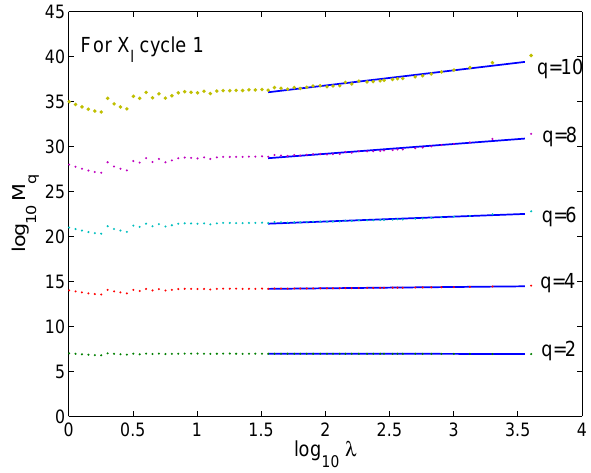
Fig. 2. An example for obtaining the empirical K(q) function. From the plots, we find the best linear fit range is from λ = 7 . 14 (around 1 week) to λ = 365 . 27 (around